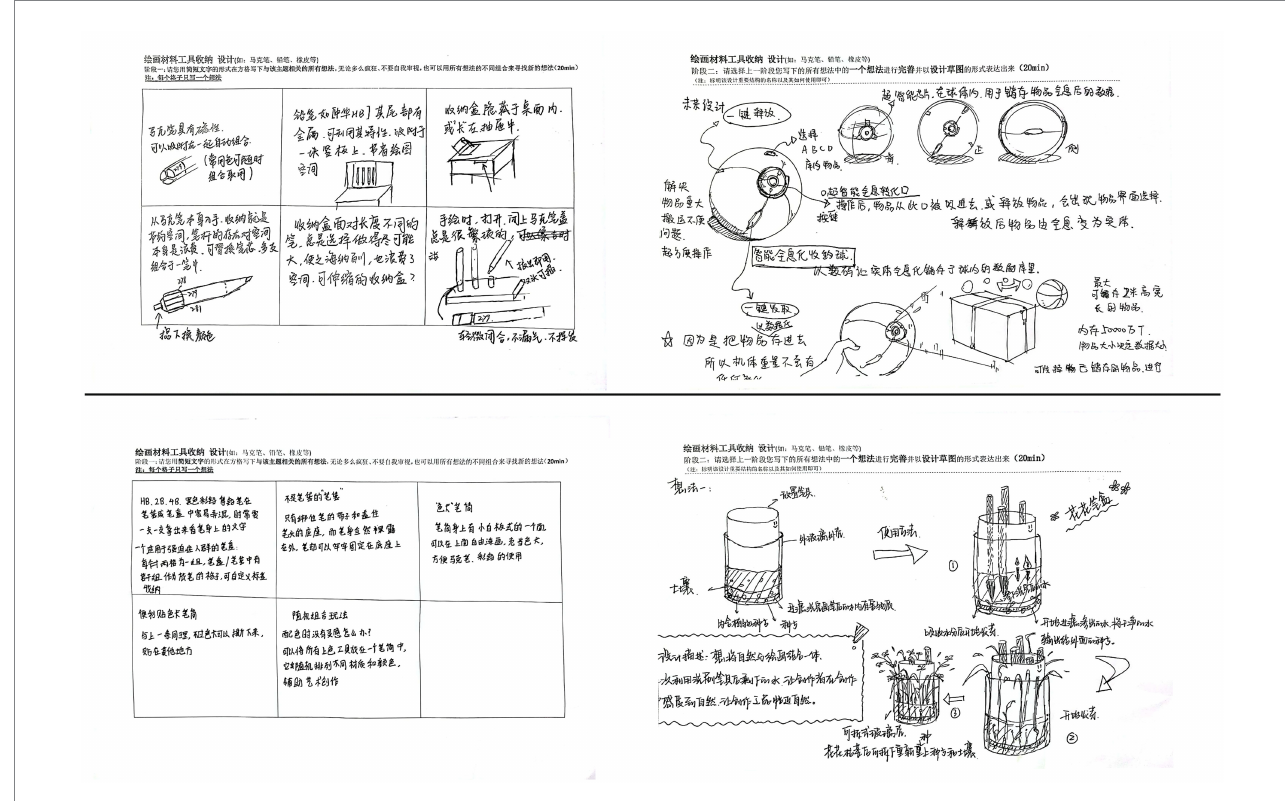
FIGURE 2 Examples of